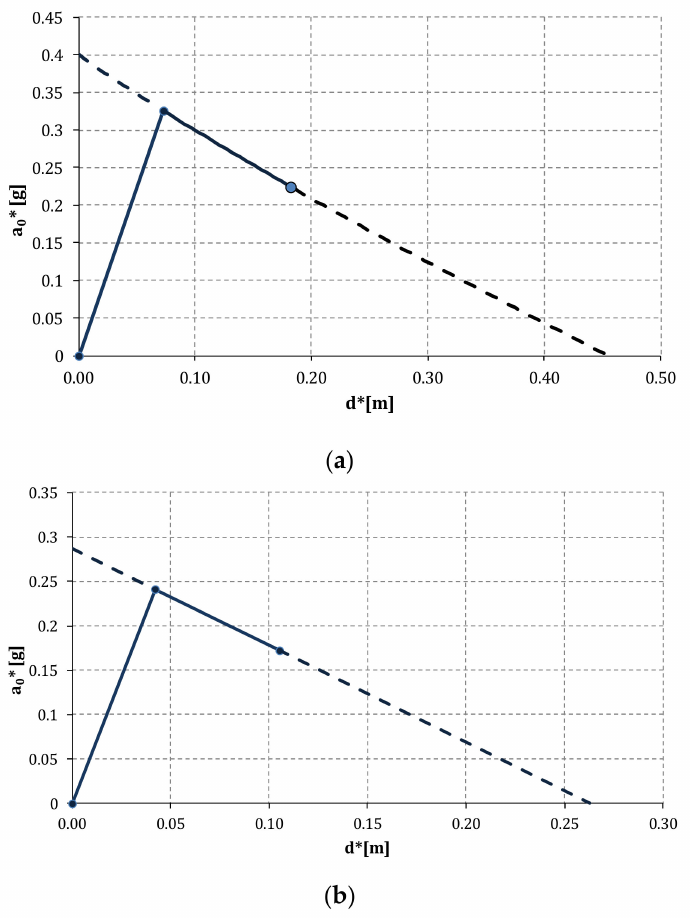
Figure 9. Capacity curves of Protaton belfry: ( a ) rocking and sliding, and ( b ) only